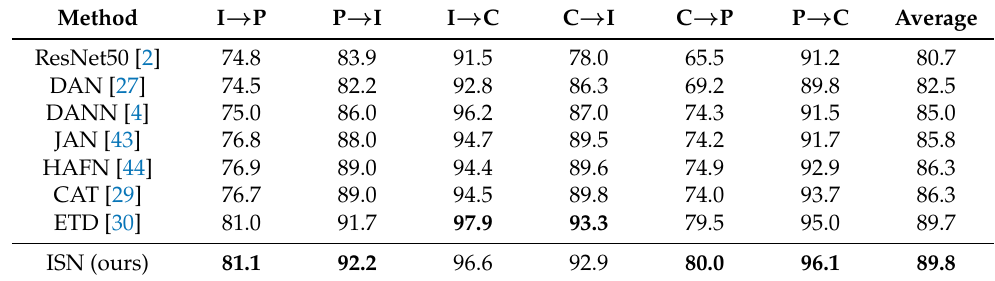
Table 6. Accuracy (%) on ImageCLEF-DA.